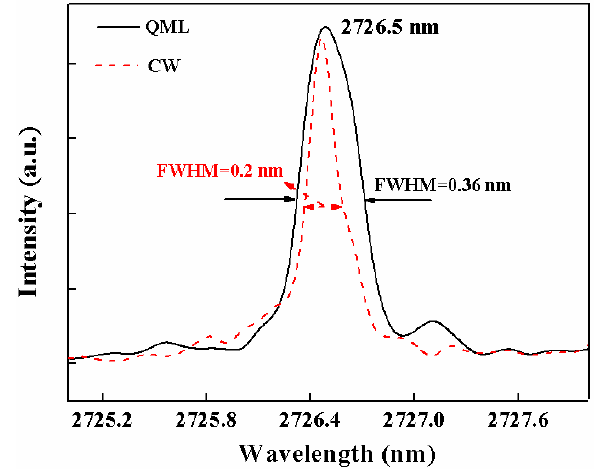
Figure 7. Output spectra in CW and QML modes of operation.